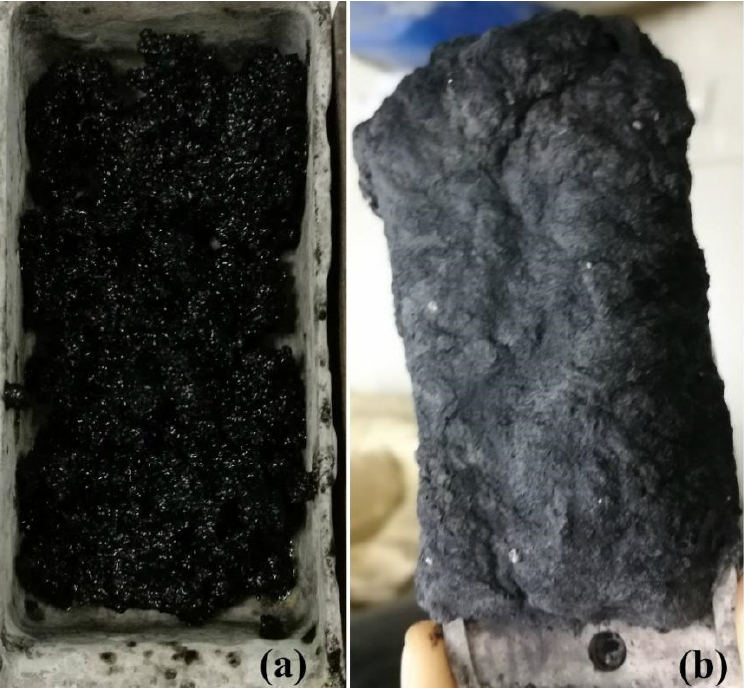
Figure 6. The macroscopic feature of carbon before and after activation: ( a ) the mixture of carbon and NaOH solution; and ( b ) the product after activation at 650 °C for 60 min.